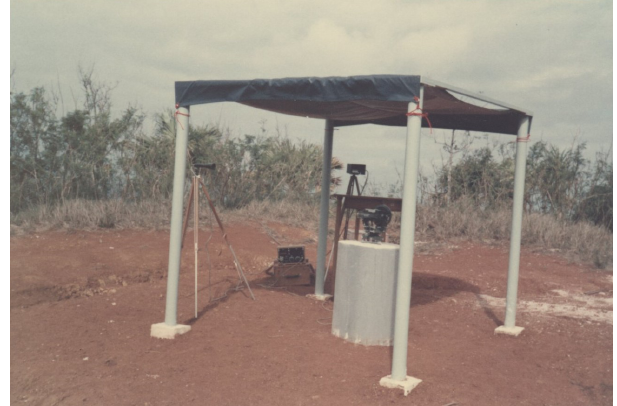
Figure 23. The pillar for the absolute measurement at Chichijima Magnetic Observatory (photo supplied by Kakioka Magnetic Ob- servatory).